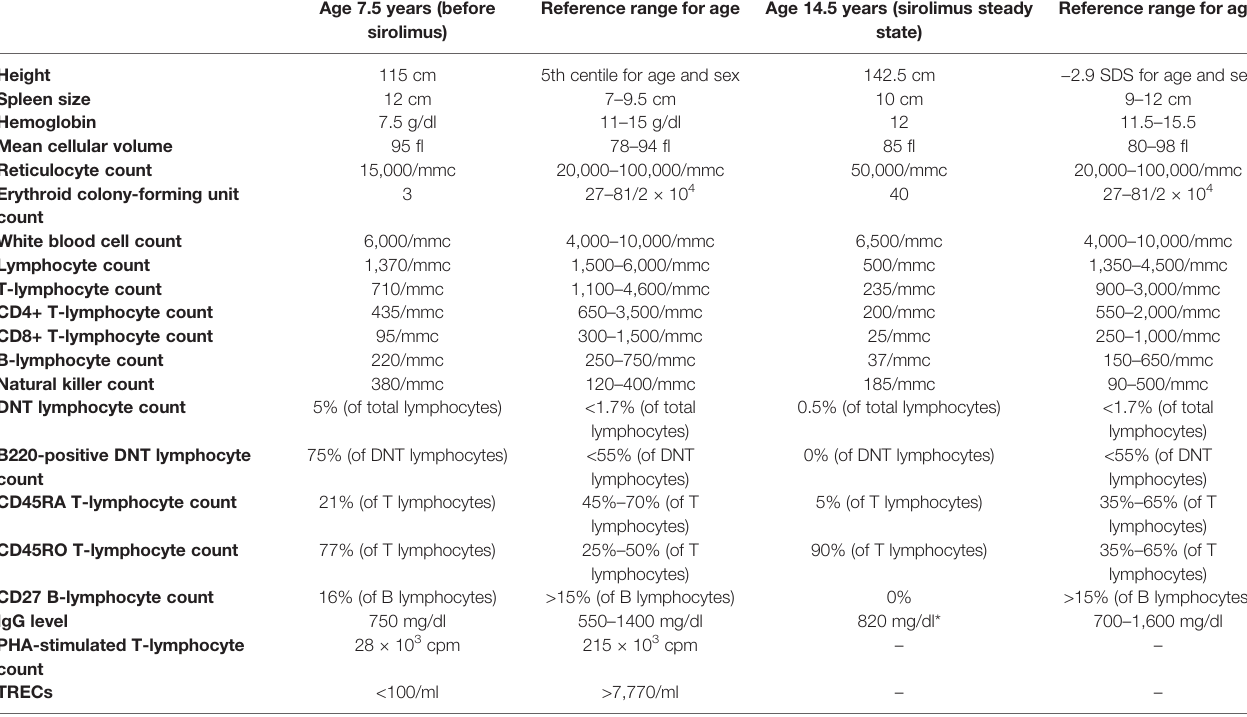
TABLE 1 | Hematological and immunological features of the